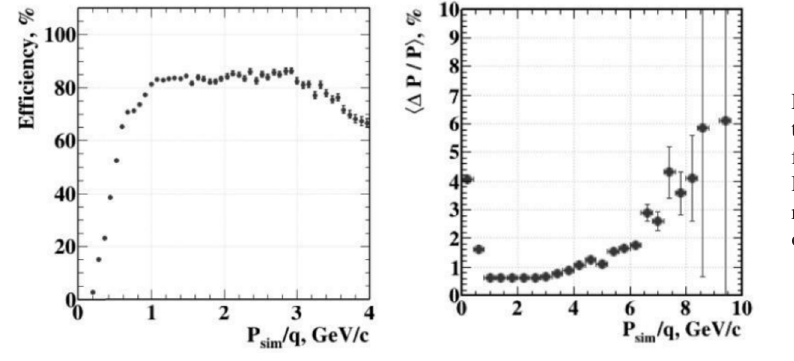
Figure 2. Left panel: tracking e ffi ciency as a function of momentum. Right panel: momentum resolution as a function of momentum.